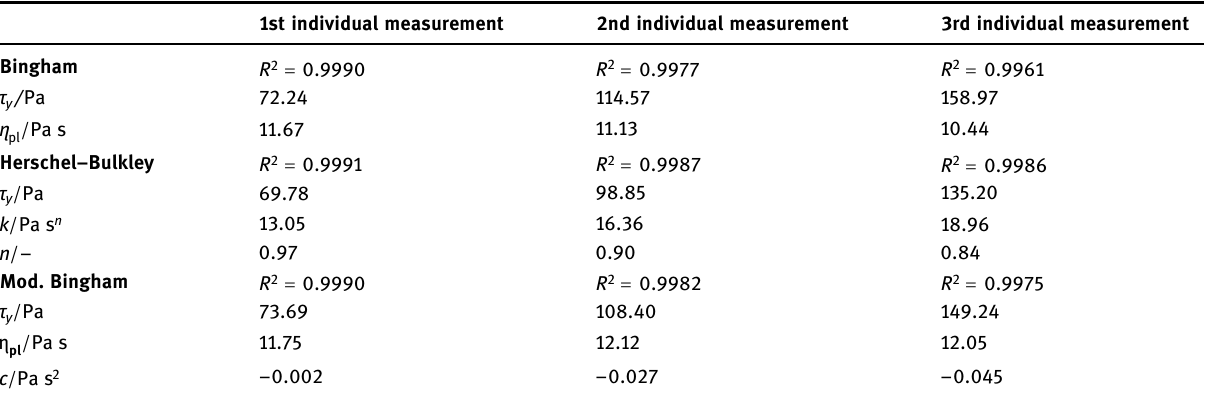
Table 2: Model parameters of the Bingham, Herschel – Bulkley, and modi fi ed Bingham model for the fi ts of the mean values of the fi rst three individual measurements of the fi rst two measurement series 1st individual measurement 2nd individual